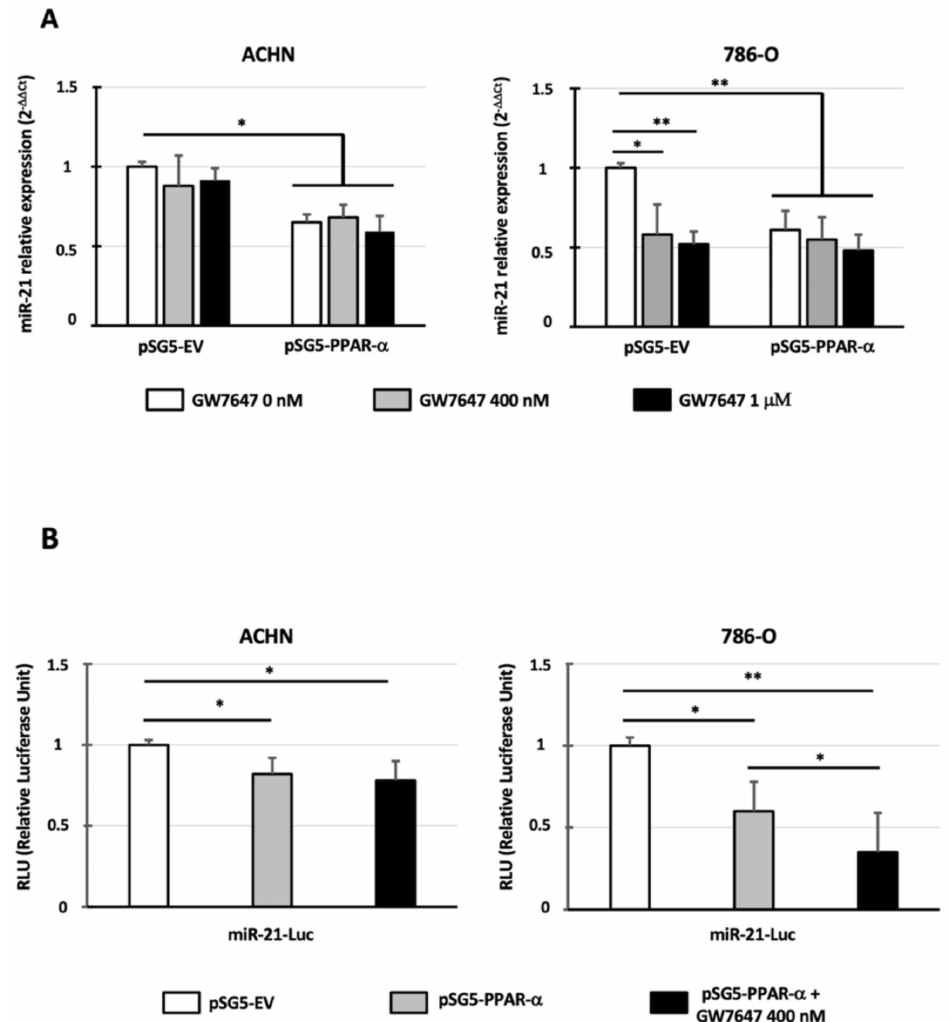
Figure 3. PPAR- α expression and/or activation decreases miR-21 expression and transcription. ( A ) ACHN and 786-O cells were transfected with pSG5-EV (empty vector) or pSG5-PPAR- α expression vectors. At 24 h after transfection, the cells were incubated with 0, 400 nM, or 1 µ M of GW7647. At 48 h after transfection, miR-21 expression was determined by qPCR. RNU48 was used as an internal control. ( B ) ACHN and 786-O cells were co-transfected with miR-21-Luc promoter and pSG5-EV (empty vector) or pSG5-PPAR- α expression vectors. At 24 h after transfection, the cells were incubated with 0 or 400 nM of GW7647. At 48 h after transfection, luciferase activity was determined. The values obtained with the empty vector were referred to as 1. The values are means ± SEM and represent at least four separate experiments (* p < 0.05 and ** p <